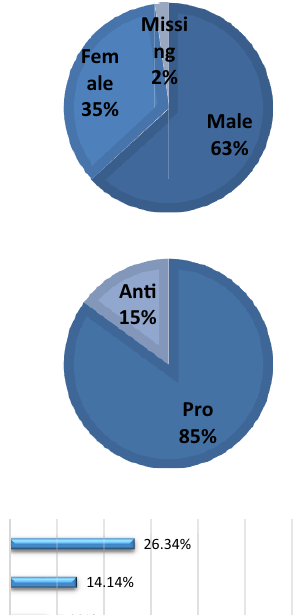
Figure 5. Categories